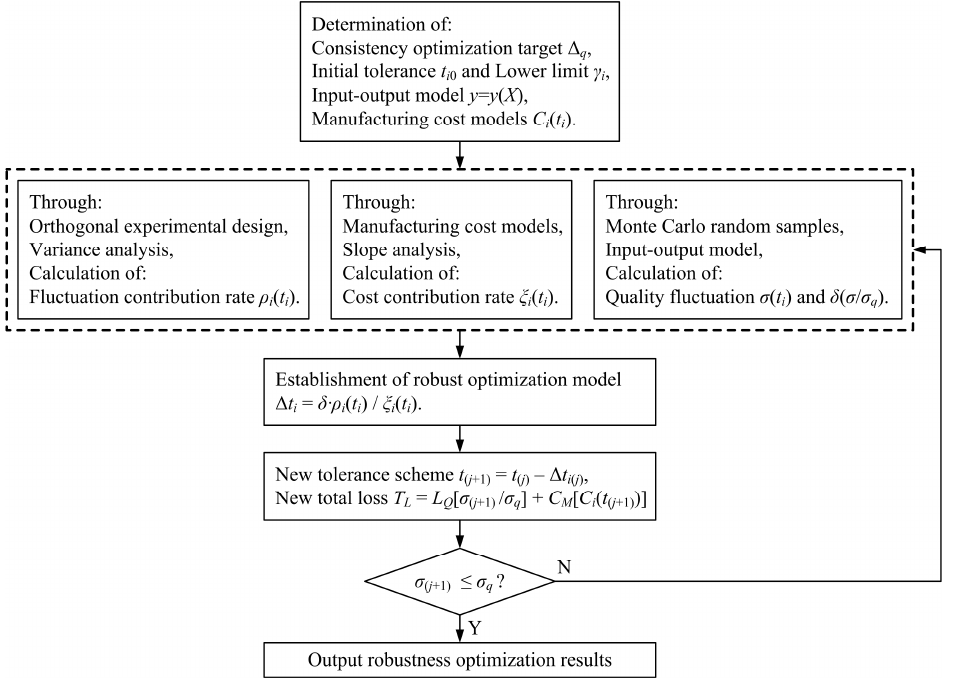
Figure 3. Procedure of robust design optimization.